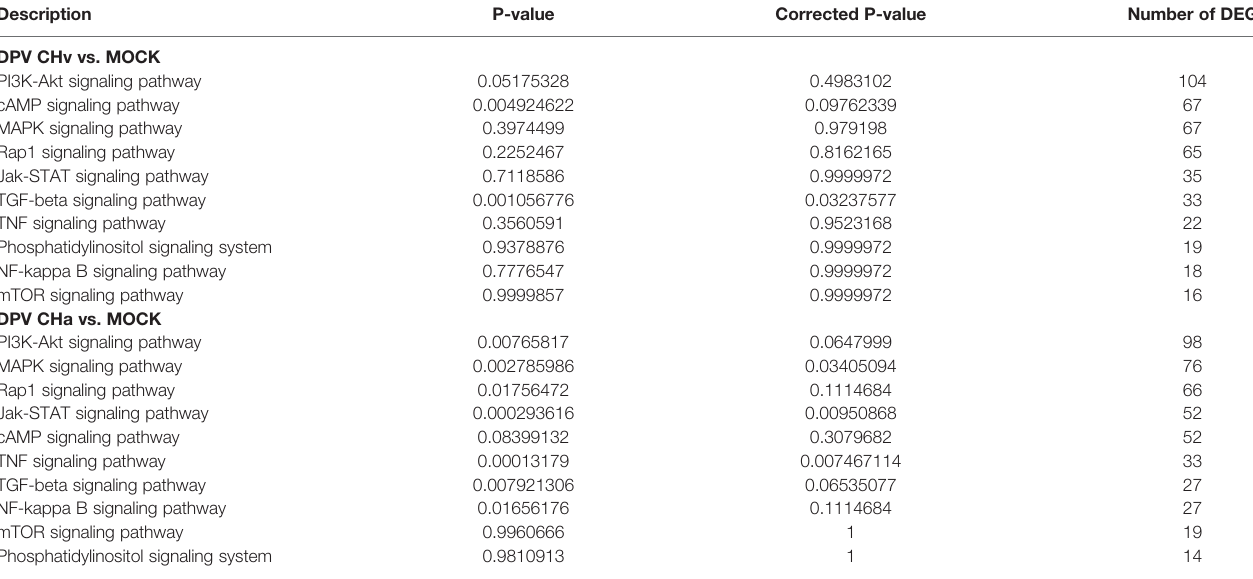
TABLE 3 | Associated with signal transduction in the transcriptome of duck monocytes or macrophages infected with DPV at 48hpi.